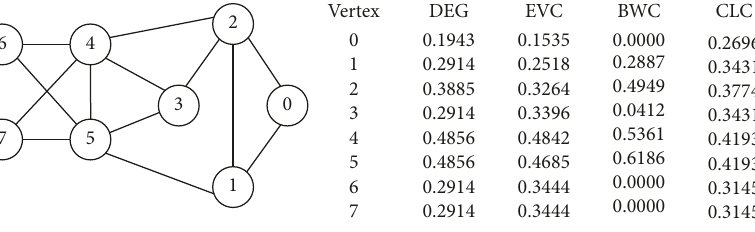
Figure 2: Example graph and the “normalized” centrality values for the vertices.